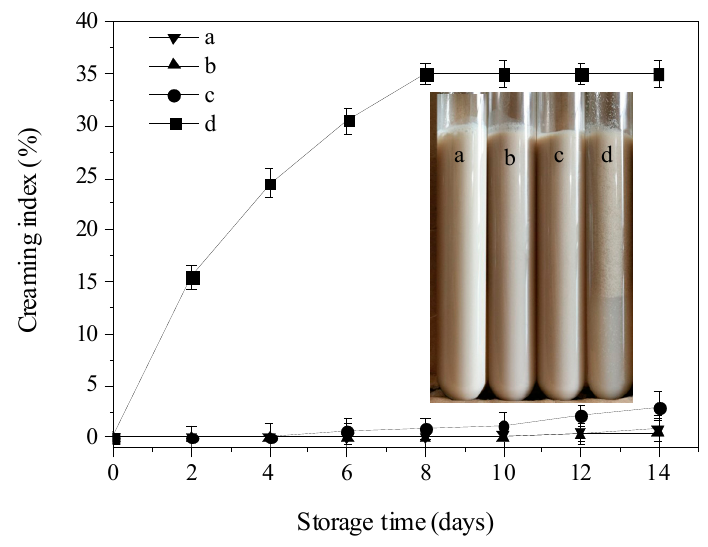
Figure 7. Influence of thermal treatment on the CI and creaming stability of PSP-stabilized emulsions. ( a ) the control (emulsion without thermal treatment), ( b – d ) emulsions with thermal treatment at 70 °C, 80 °C, 90 °C for 30 min, respectively. Values are means ± SDs (n = 3).